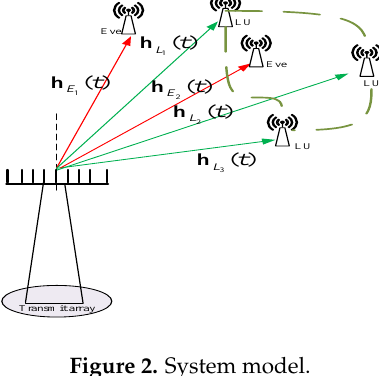
Figure 2. System